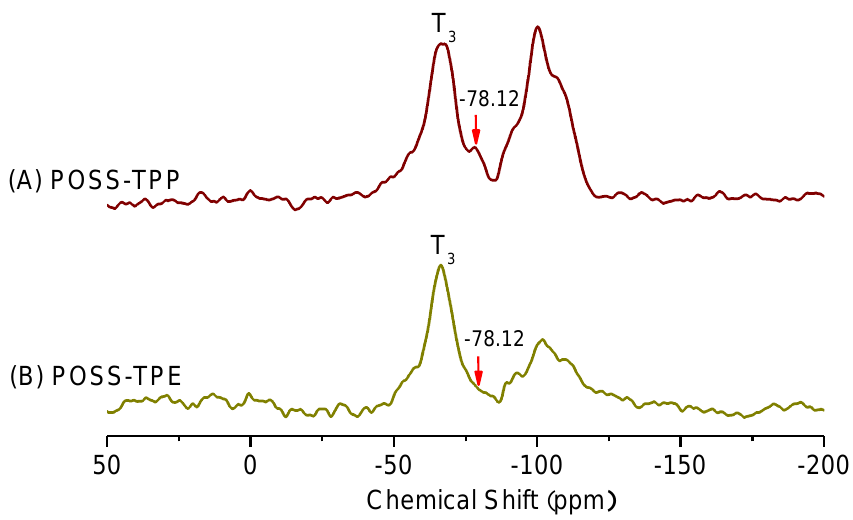
Figure 4. 29 Si spectra of ( A ) POSS-TPP and ( B ) POSS-TPE.